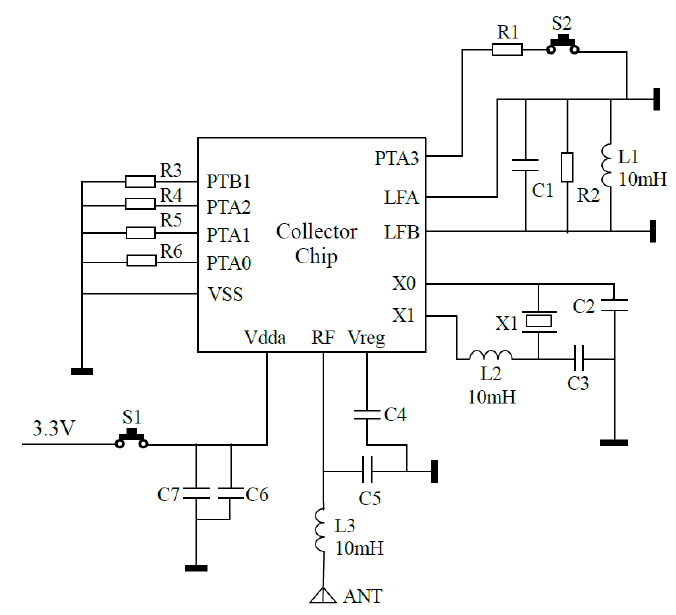
Figure 6. Node circuit schematic diagram.